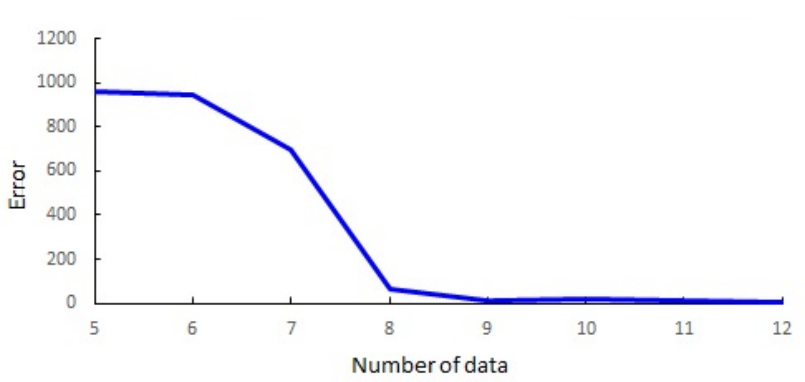
Figure 4. Focal length estimation error depending on the number of foot-head data sets with 30% outliers.